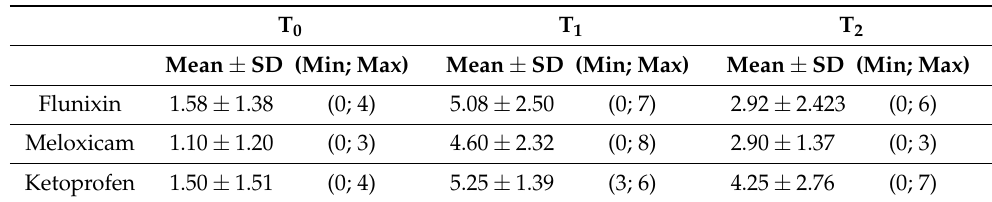
Table 2. Mean ± standard deviation of pain scores, depending on time and NSAIDs. Pain scores were assessed before NSAID administration (T 0 ), after recovery from anesthesia (T 1 ) and after the second NSAID administration (T 2